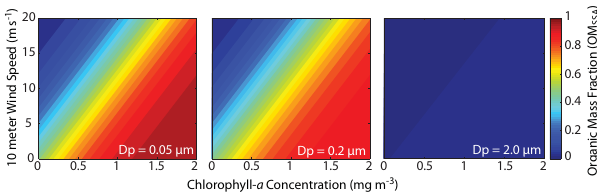
Fig. 5. Contour plots of the organic mass fraction of sea spray aerosol as a function of [Chl- a ] and 10m wind speed ( U 10 ) for sea spray aerosols with ambient aerodynamic diameters of (a) 0.05, (b) 0.2, and (c) 2µm. Fig. 6. Annual average submicron marine POA emission rate in units of ngCm − 2 s − 1 using the M˚artensson et al. (2003) sea spray function, monthly average climatological [Chl- a ] from SeaWiFS, modeled U 10 from the CAM5 “current climate” (not based on any particular year), and the estimated global submicron marine POA emissions of 2.8TgCyr − 1 . See text for more